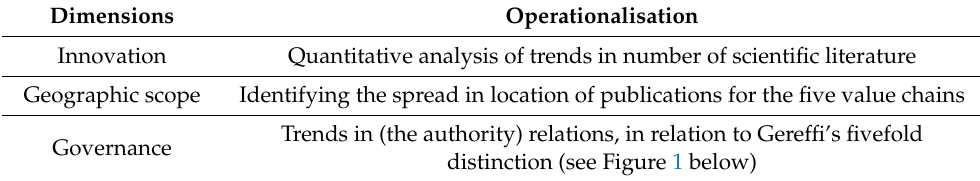
Table 1. Operationalisation of the three dimensions (Based on Gereffi & Fernandez-Stark